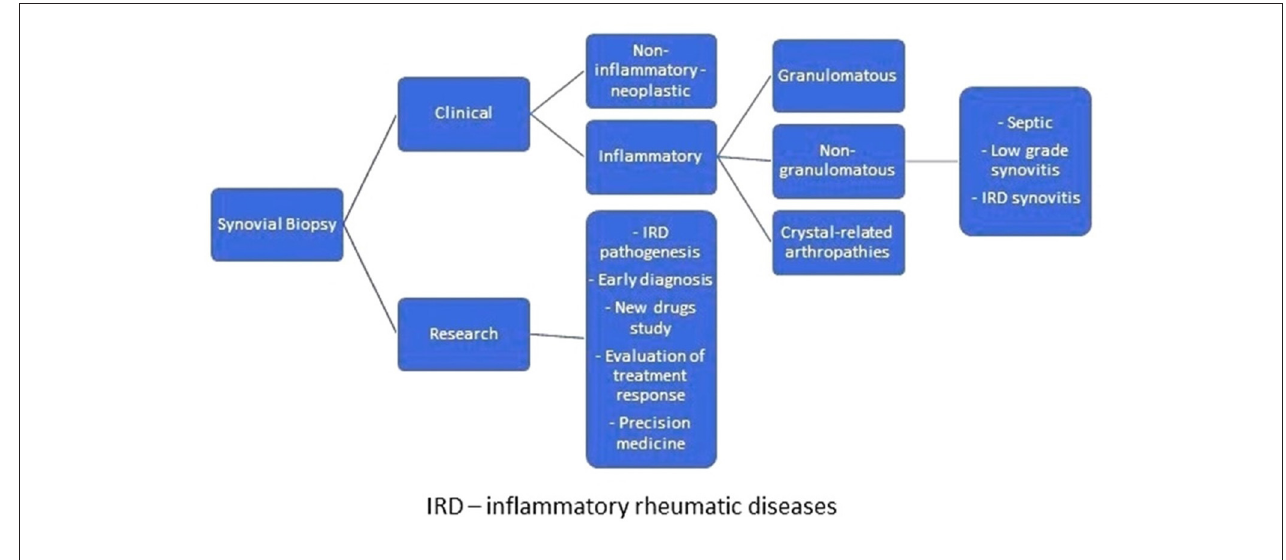
FIGURE 1 | Why are synovial biopsies conducted?